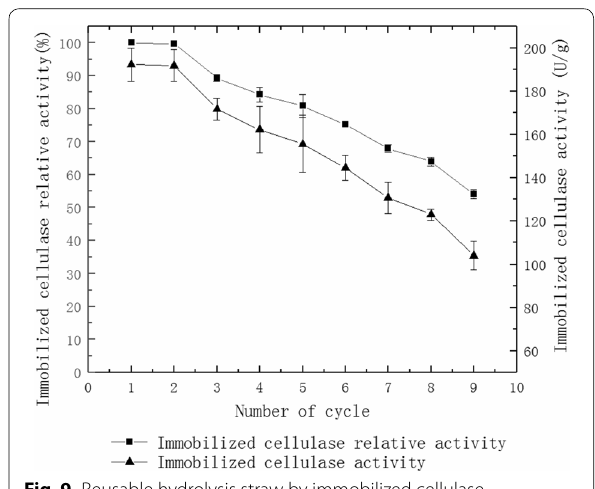
Fig. 9 Reusable hydrolysis straw by immobilized